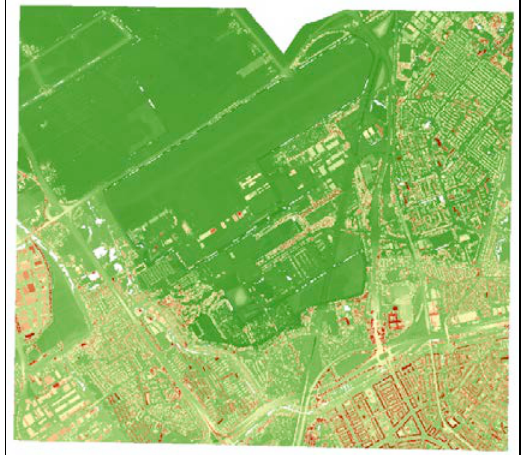
Figure 3. Test case area with various assets and their representation in the